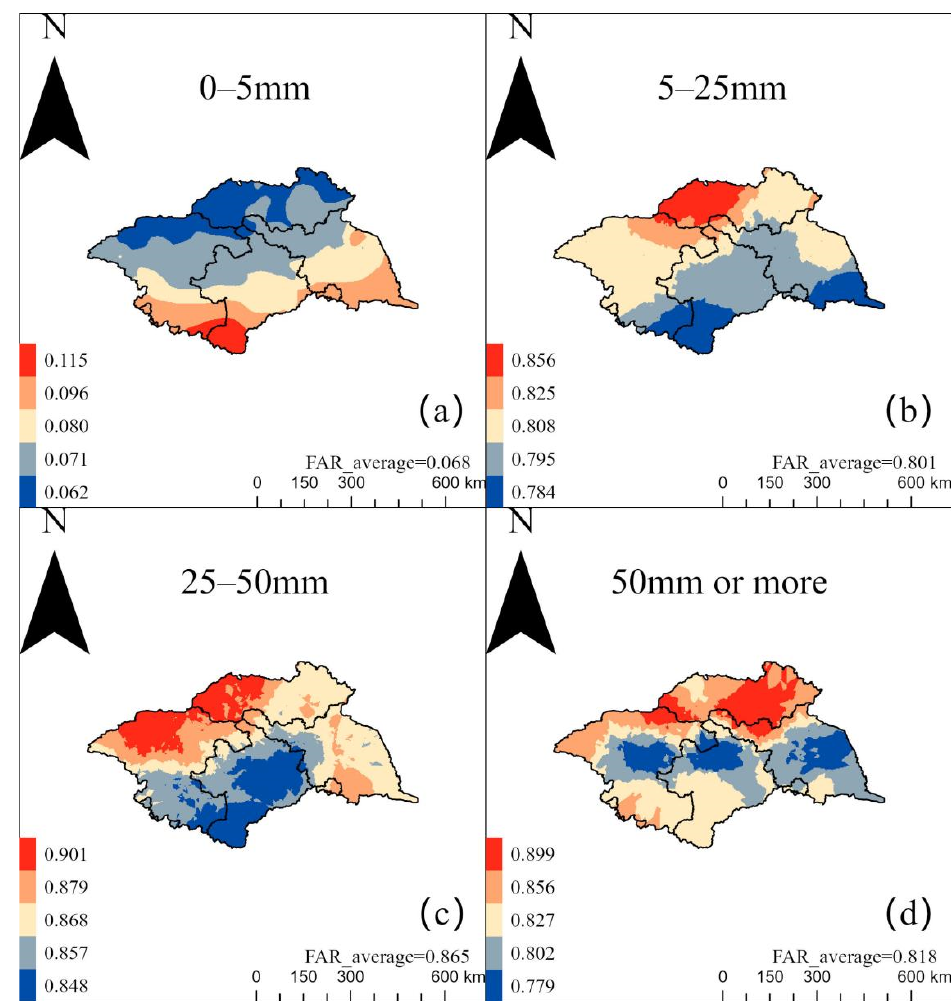
Figure 4. The false alarm ratio (FAR) of daily PERSIANN-CDR estimates in different magnitudes: ( a ) 0–5 mm, ( b ) 5–25 mm, ( c ) 25–50 mm, and ( d ) >50